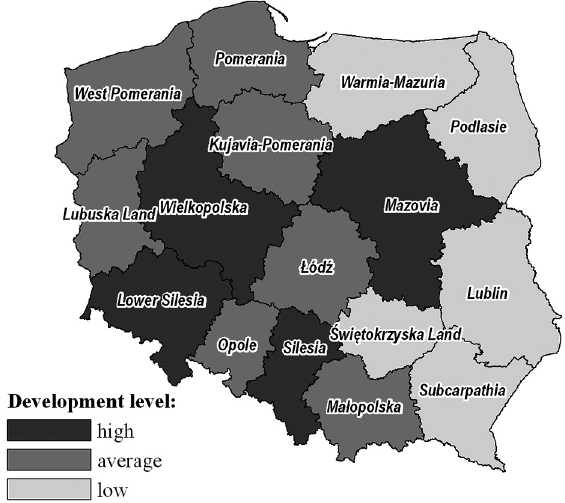
Fig. 1. Regional differences in Poland in 2005 Source: own compilation